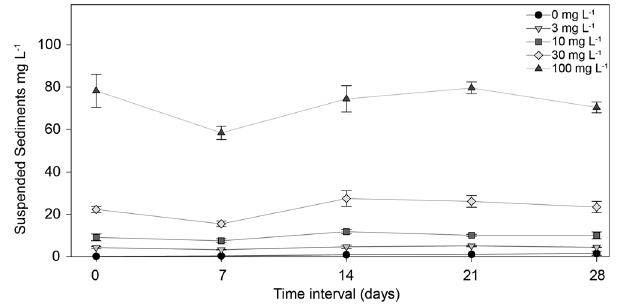
Figure 1. SSC during the experiment. ( a ) Means ( ± SE) SSCs (mg L − 1 ) at each treatment, according to gravimetric